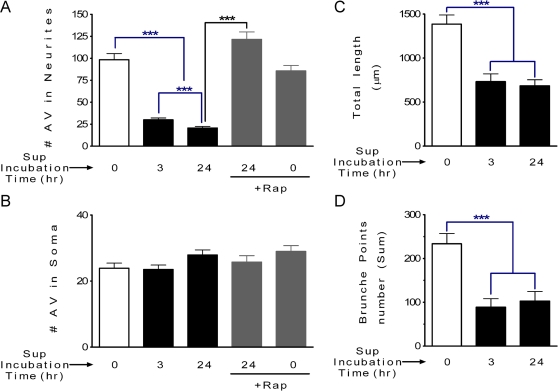
Process length and AV distribution in neurons exposed to different treatments.(A) The number of AV in neurites decreased significantly in neurons exposed to the SIV-infected microglia supernatant for 3 or 24 hr, however; pretreatment with rapamycin blocked this effect. *** P<0.001, for n = 6 experiments. Scale bar, 20 µm. (B) The AV number is unchanged in neuronal soma after exposure to the SIV-infected microglia supernatant for 3 or 24 hr. (C and D) Both the total length of neuronal processes (C) and number of brunch points (D) are decreased after exposure to after SIV-infected microglia supernatant treatment. *** P<0.001, for n = 6 experiments. All values are mean±SEM.